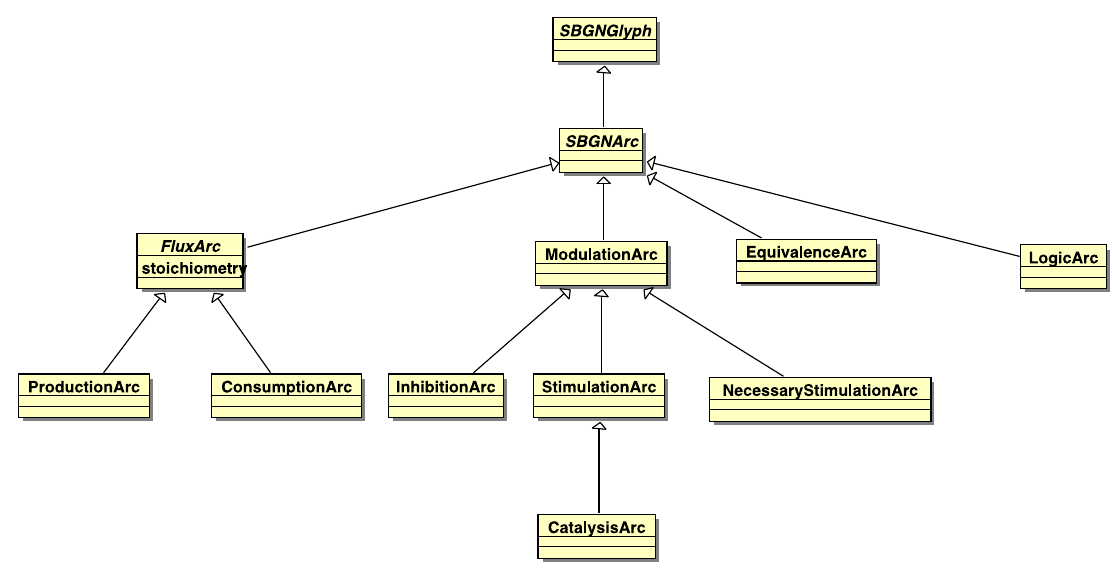
Figure 3.2: Organisation of the edge glyphs within SBGN Process Description language. All UML classes (boxes) correspond to Process Description node glyphs except those with italicised names, which are organisational groupings. They correspond to the groupings used elsewhere in this